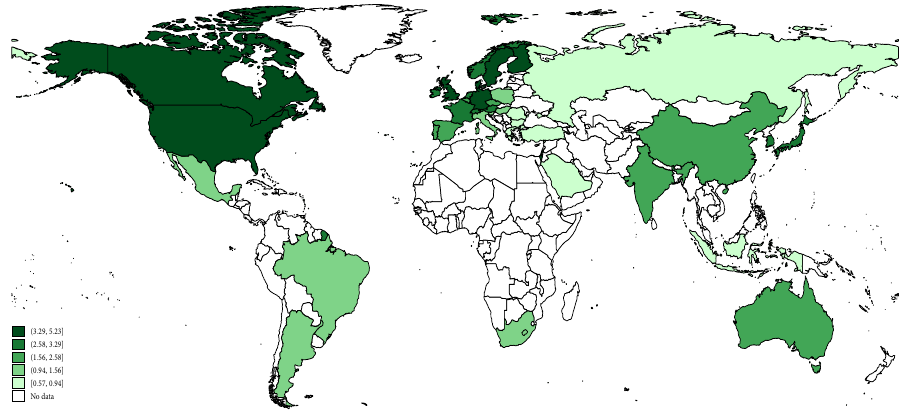
Figure 4. Outputs of Innovation